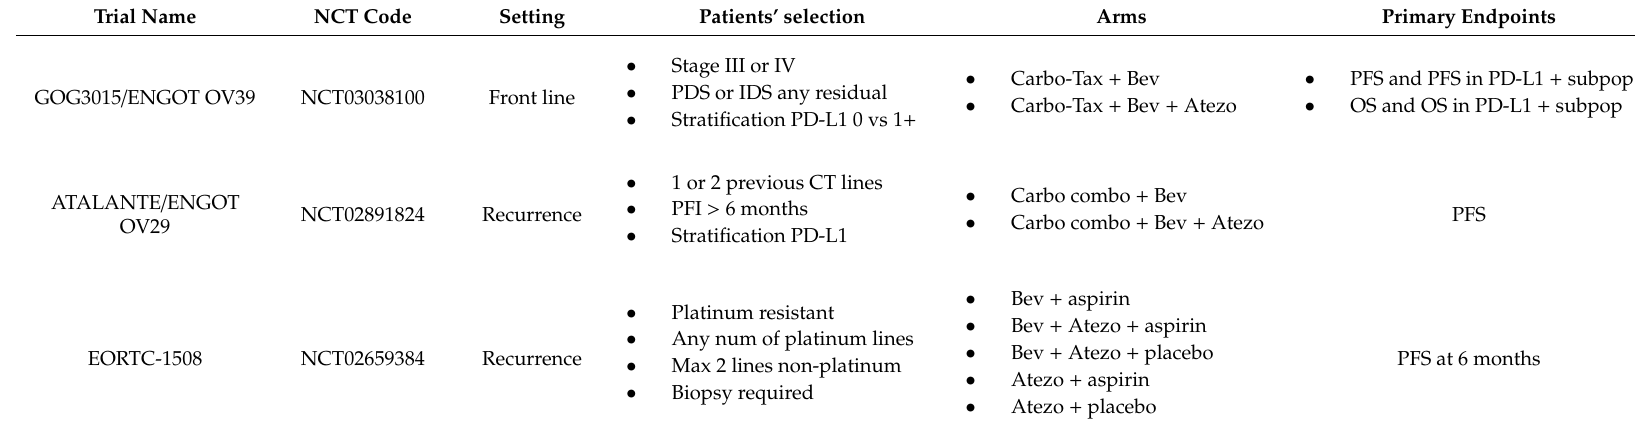
Table 1. Ongoing phase III clinical trials exploring CPIs and anti- vascular endothelial grow factor